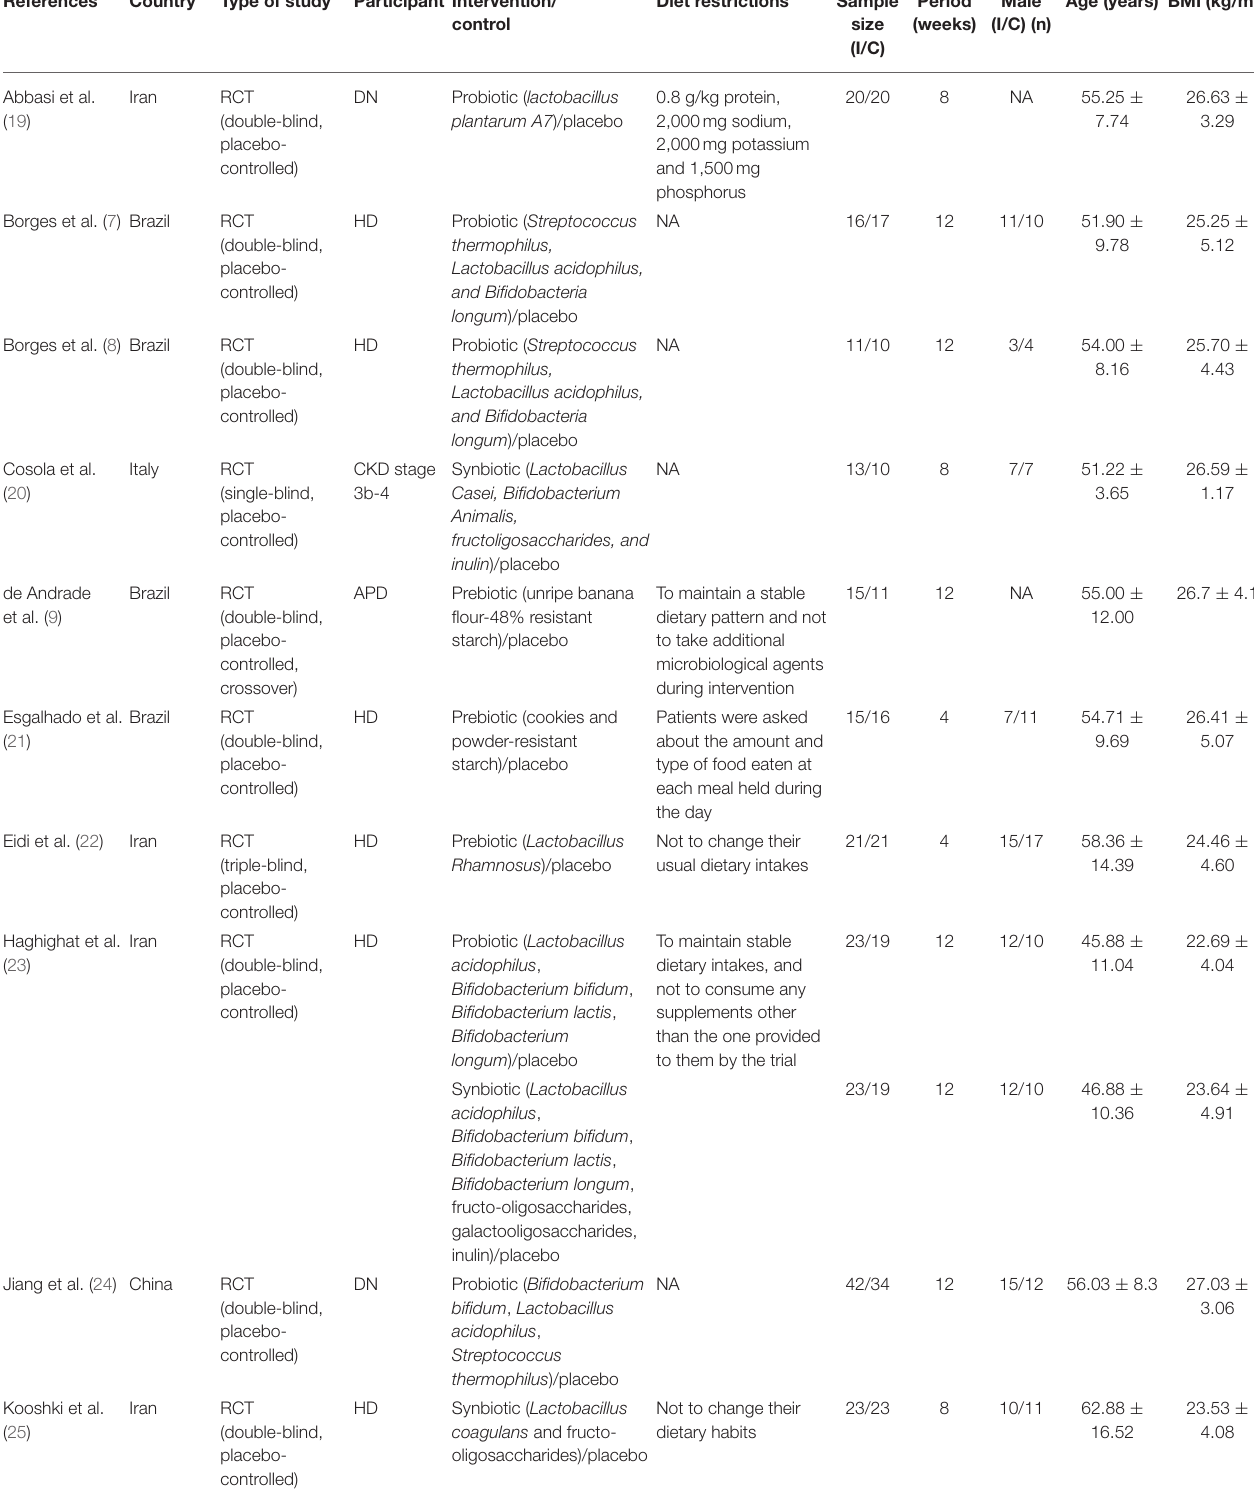
TABLE 1 | Basic characteristics of the included